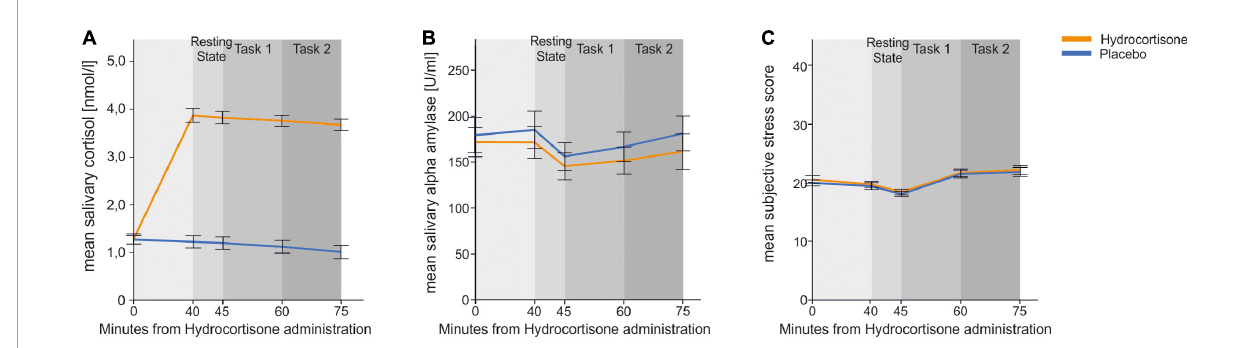
FIGURE2 Physiological and subjective endocrinological and subjective response to hydrocortisone and placebo administration. Error bars represent 1 ± standard error of the mean (SEM). The first measurement was taken before tablet administration. (A) Mean cortisol (log-transformed in the figure only for presentiveness) (B) mean salivary alpha-amylase and (C) mean subjective stress responses measured by SERS for each time point.